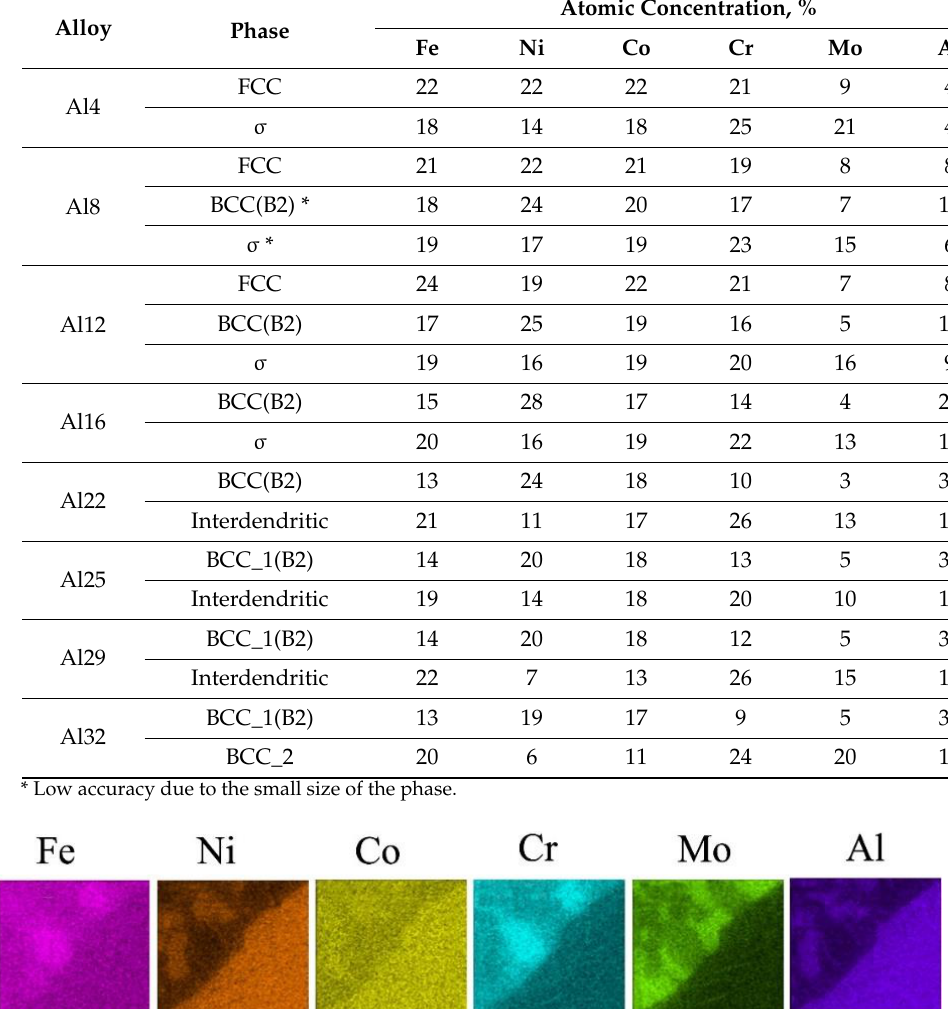
Table 3. Composition of the phases determined with EDS.